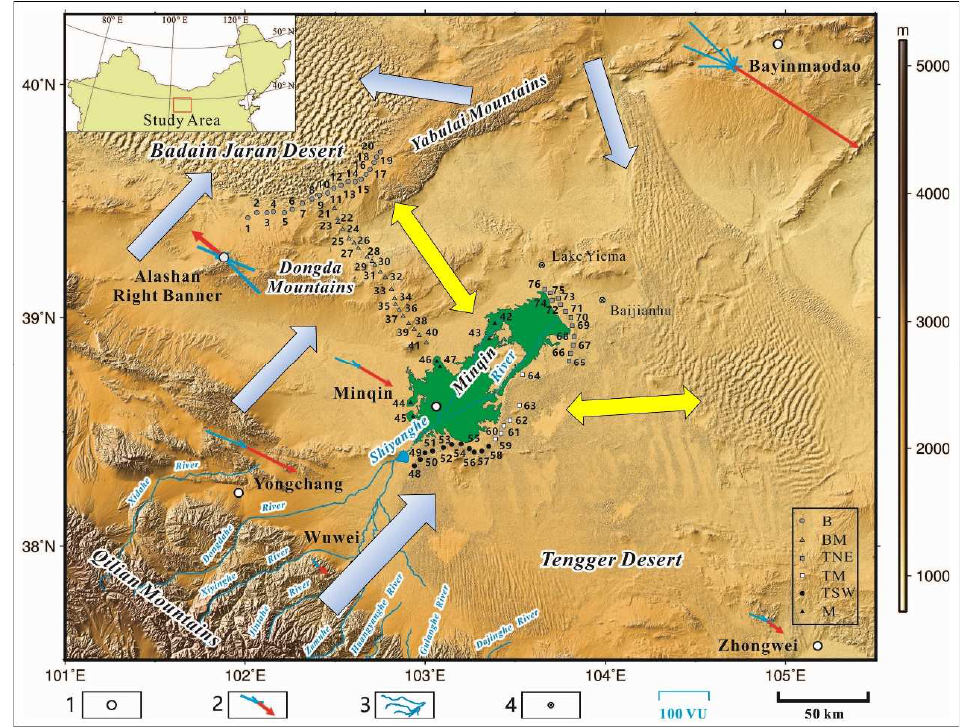
Figure 14. Potential source areas of desert sands on the Alashan Plateau indicated by different arrows (revised from Ren et al., 2014) [21]. B, Sampling sites in the Badanjilin Desert. BM, Sampling sites along dune belt from the Badanjilin to the Minqin Oasis. TNE, Sampling sites at the northeastern edge of the Minqin Oasis. TM, Sampling sites at the southeastern edge of the Minqin Oasis. TSW, Sampling sites at the southern edge of the Minqin Oasis. M, Sampling sites in the area of the Minqin Oasis. 1, Weather stations. 2, Sand rose. 3, River. 4, Sedimentary sequence sites. Sand roses for each of the five surrounding weather stations, with blue lines showing winds capable of transporting sand from various directions (DP) and red arrows indicating the resultant sand transport trends (RDP). For interpretation of the references to color in this figure legend, the reader is referred to the web version of the paper by Ren et al. (2014)